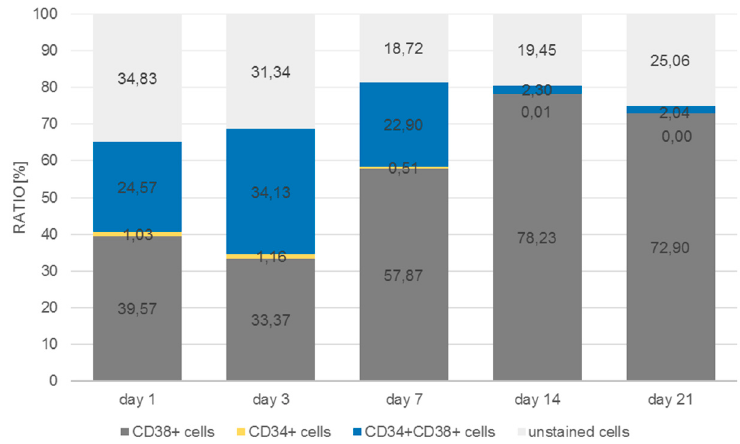
Figure 12. Distribution of CD34 + , CD38 + , CD34 + / CD38 + , and unstained cells in monolayer over a period of 21 days.